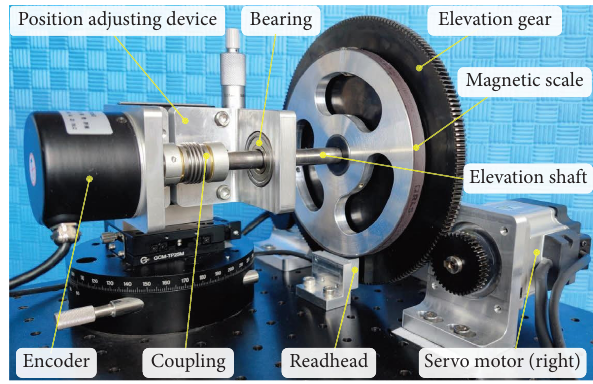
Figure 4: Te measurement experiment platform of the error of the elevation mechanism.